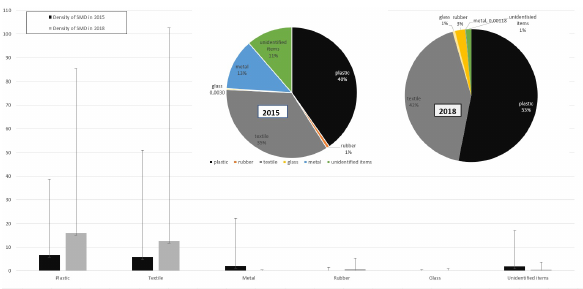
Figure 4. The average abundance of each category of debris collected in the prospected area in (kg/ km 2